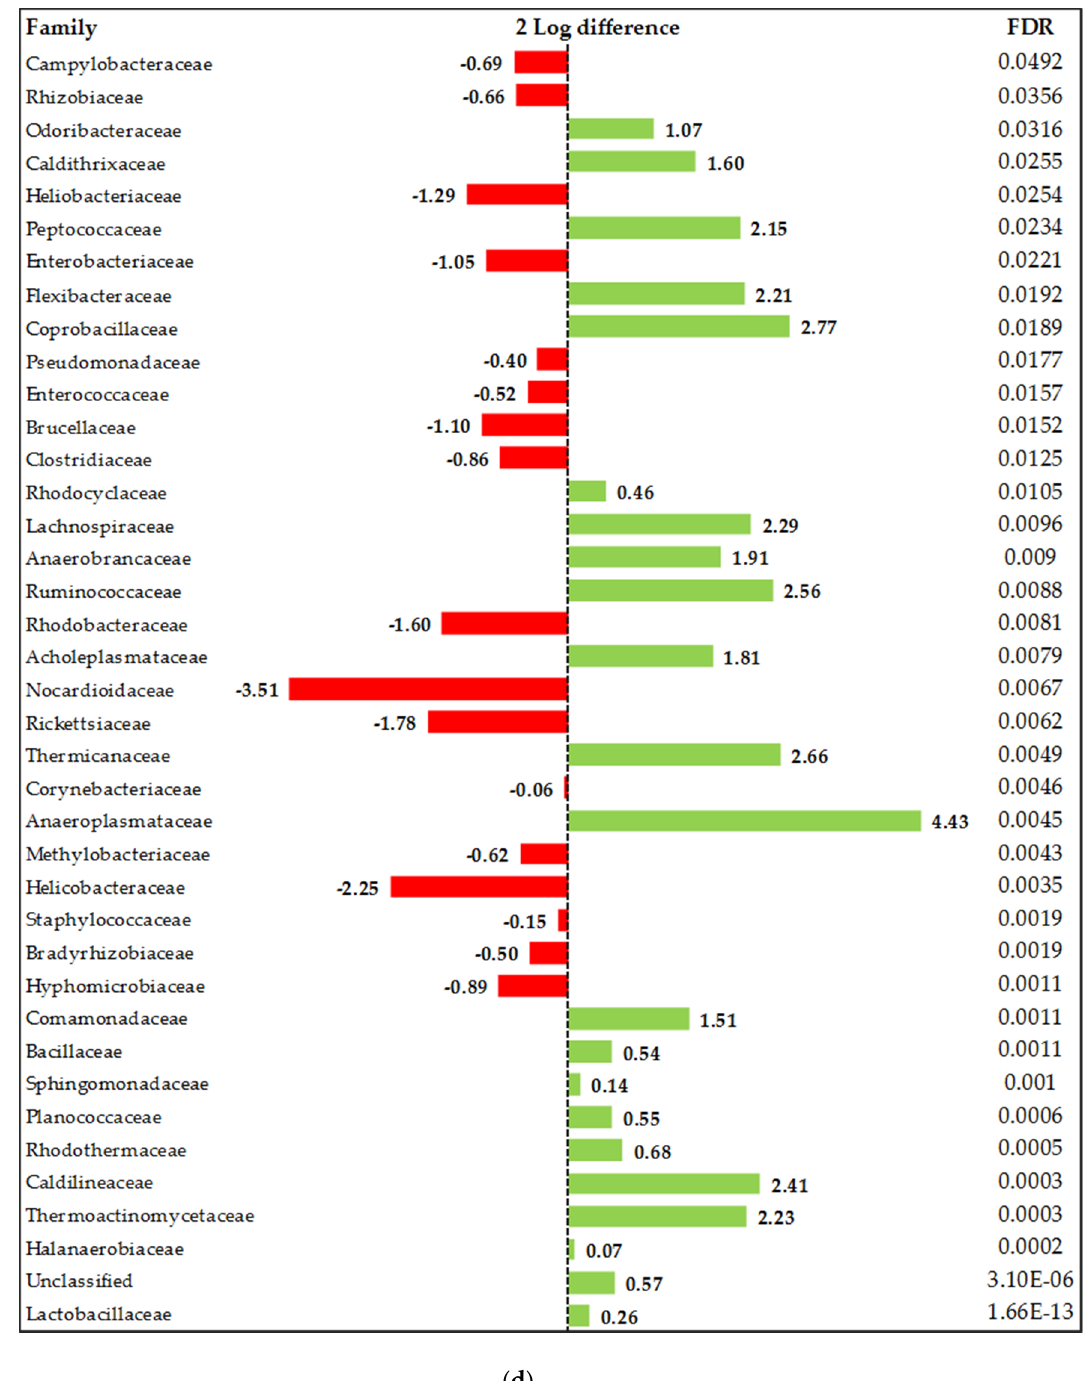
Figure 3. Differentially abundant taxa (family) from the ileum (in change and FDR-adjusted, p ≤ 0.05) on d 42 between OA1 + AC vs. NC ( a ); OA2 + AC vs. NC ( b ); MCFA + AC vs. NC ( c ); MCFA + OA3 + AC vs. NC ( d ). NC: Negative control; OA1: Malic acid + fumaric acid; OA2: Calcium butyrate